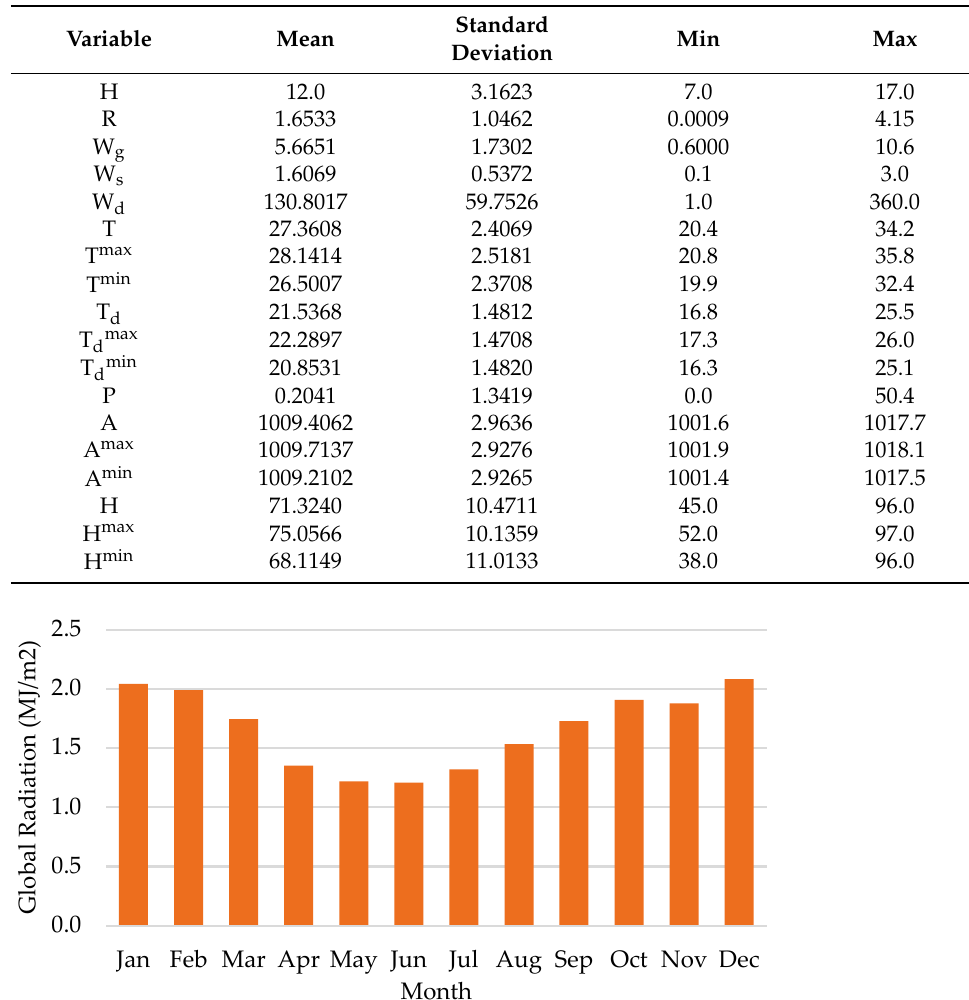
Table 2. Statistical features of the available database.